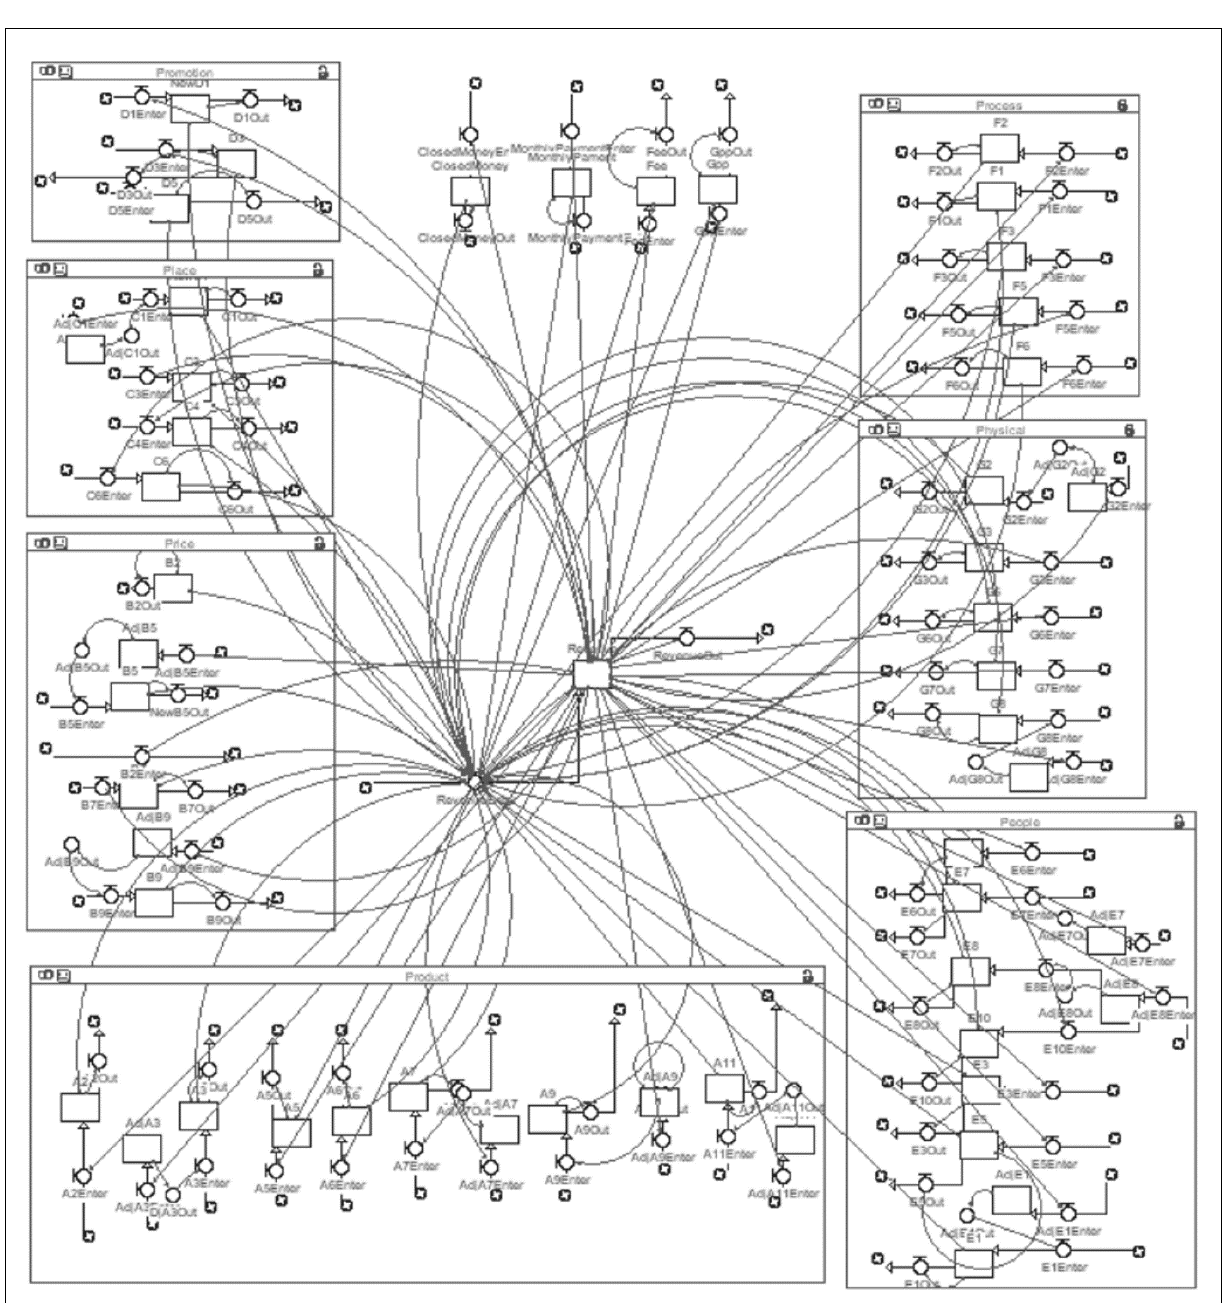
Figure 6. Revenue model by system dynamics.